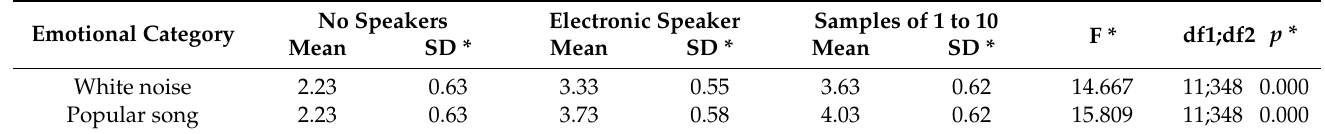
Table 12. Comprehensive evaluation of soundscape